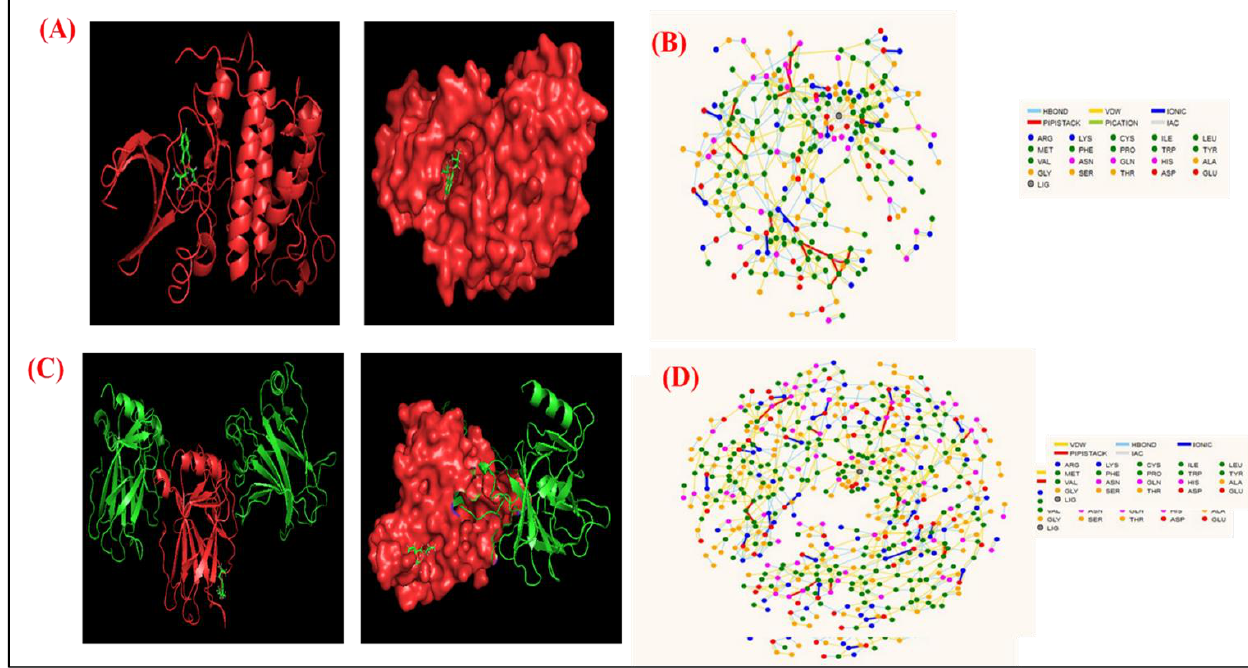
Figure 15. Docking conformations (PatchDock server) showing the interaction of BDCe fraction with the p53 and CDK2 binding site with minimum binding energy, ( A ) CDK-1-BDCe fraction complex with a binding energy of − 133.96 kcal/mol; ( B ) CDK1-BDCe fraction RIN plot ( C ) p53- BDCe fraction with a binding energy of − 151.13 kcal/mol; ( D ) p53-BDCe fraction RIN plot. RIN analysis (RING 2.0 web server) used to show interactions among